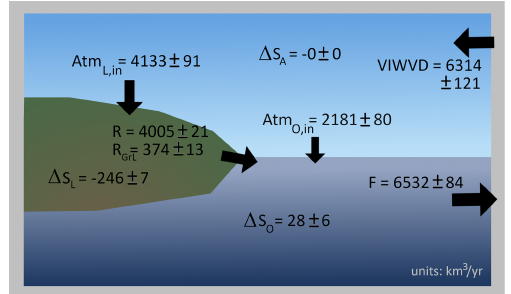
Figure 12. 1993–2018 adjusted long-term means of atmospheric and terrestrial freshwater fluxes and storage terms in the Arctic hy- drological cycle as well as oceanic volume transport and storage change. Units are km 3 yr − 1 ; arrow areas are scaled by the magni- tude of the represented